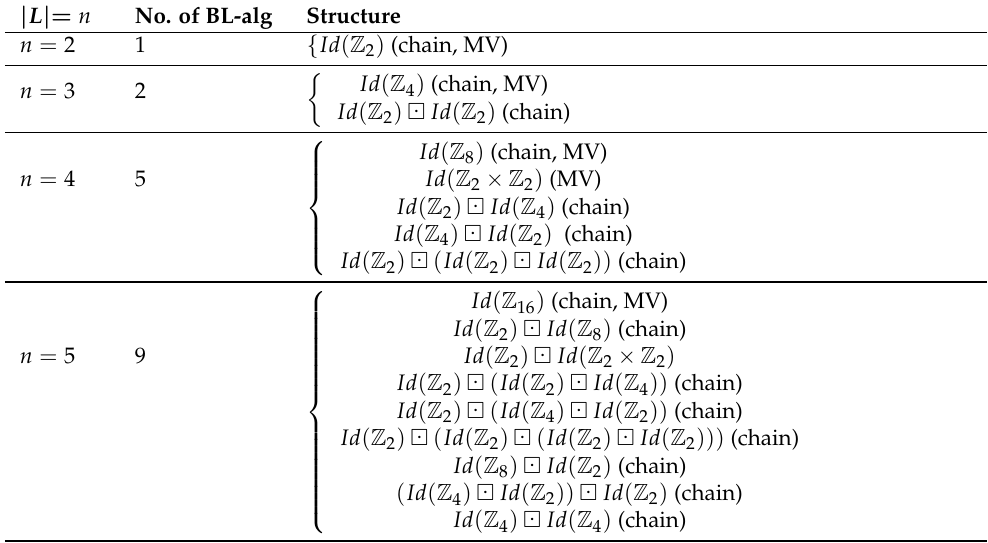
Table 2. The structure of BL-algebras of order n , 2 ≤ n ≤